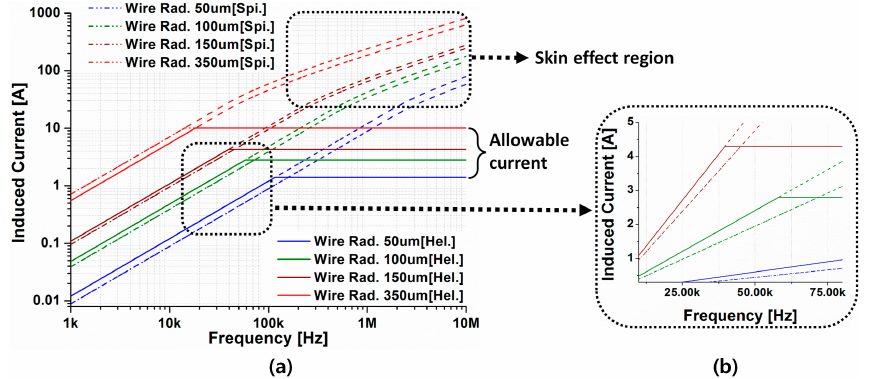
Figure 5. Induced current with 3 mm × 3 mm load coil in relation to the frequency under allowable current ( a ), and figure showing the different in slope ( b ).